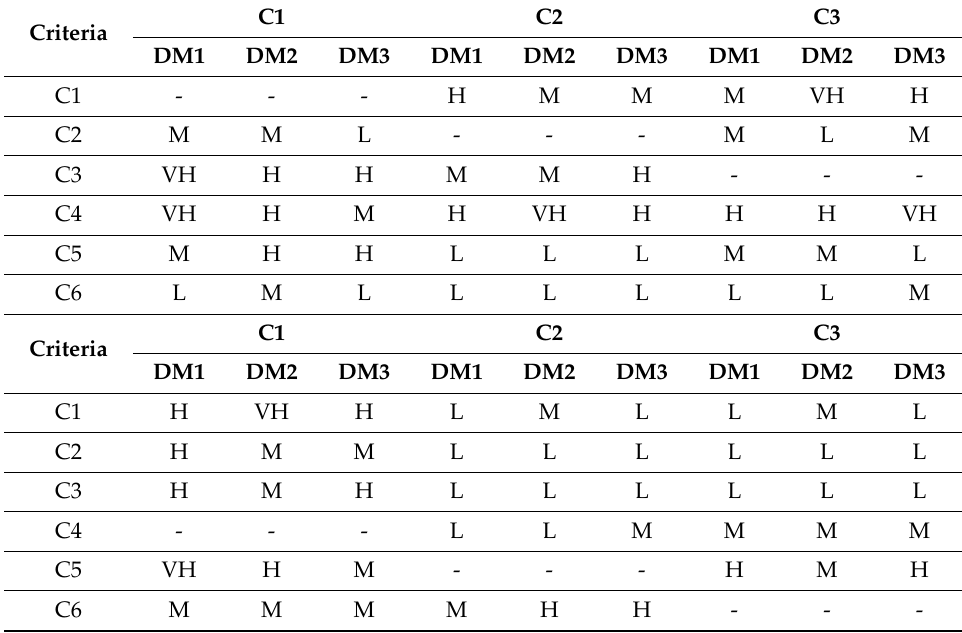
Table 3 defines the linguistic choices of each criterion provided from the experts for determining the mutual relationship of criterion set. Table 3. Linguistic choices of the decision makers for the